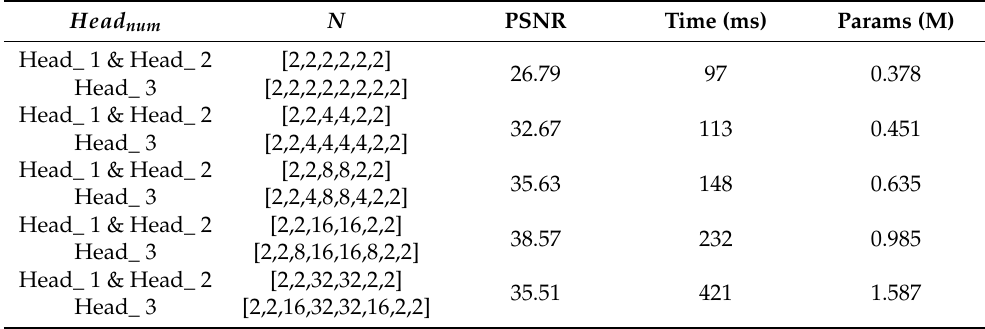
Table 3. Ablation experiments for the number of LK blocks N on the self-built dataset for maritime image dehazing